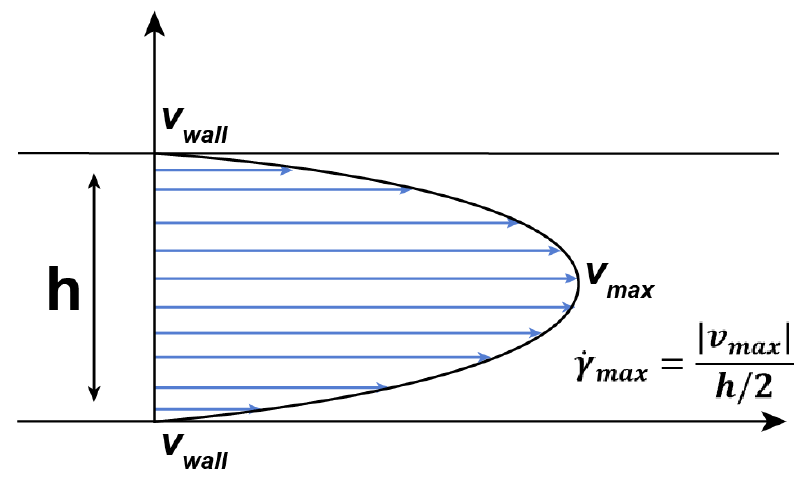
Figure 9. Poiseuille profile of the fluid flow and approximate shear